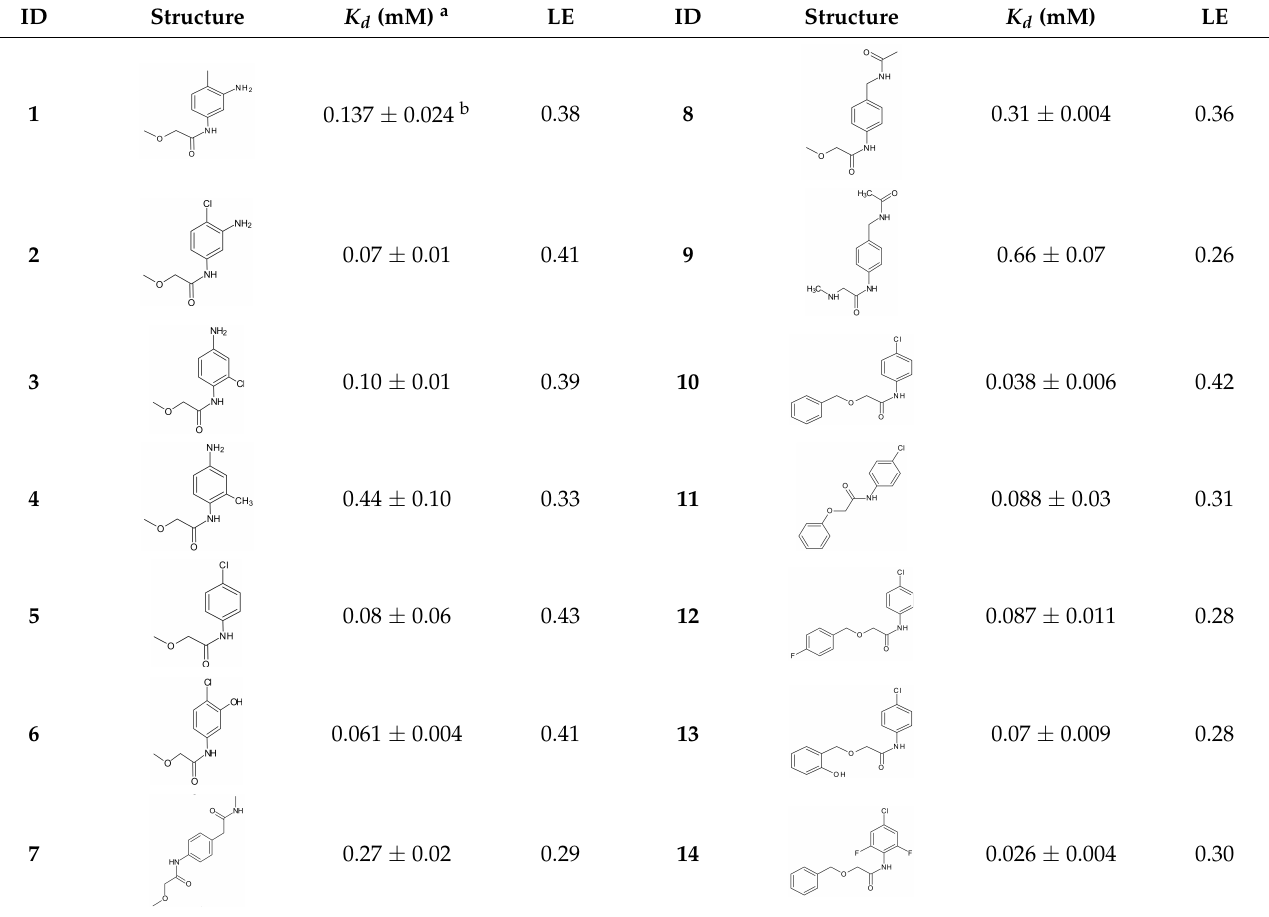
Table 1. Structure and affinities of fragment-derived inhibitors of the AF9 YEATS domain.